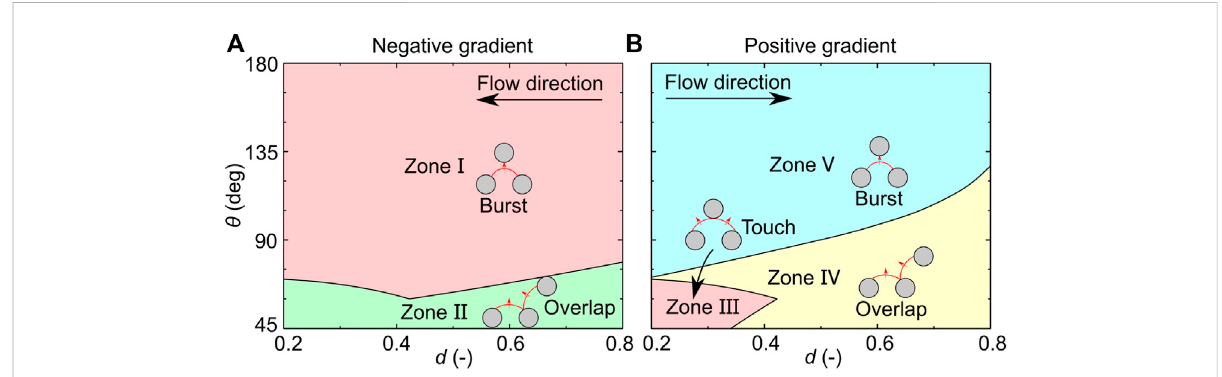
FIGURE 5 Transition of local invasion morphologies on the d - θ plane in negative gradient porous media (A) and positive gradient porous media (B) . Red, green,andblueindicatethecompactfront,taperedfront,andsingle fi ngering,respectively.Yellowindicatesthatboththetaperedfrontandwidened fi ngering can occur in this zone, depending on which local invasion morphology it is adjacent to. The fl ow directions represent that the invasion phaseinvadesalongtheporesizedecreasingdirectioninthenegativegradientporousmediaandalongtheporesizeincreasingdirectioninthe positive gradient porous media.